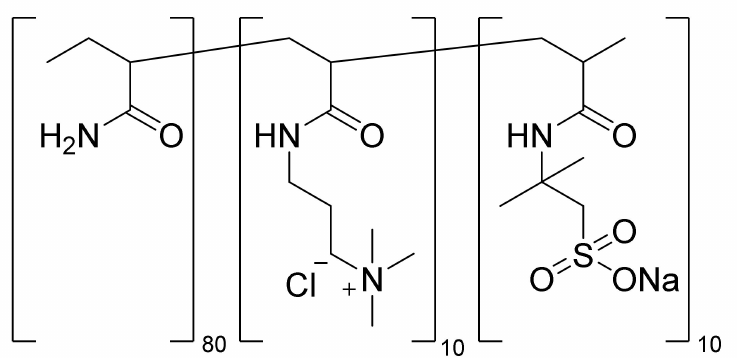
Figure 3. Repeating monomeric units and composition of TPA